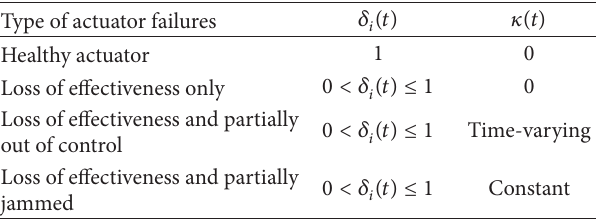
Table 1: Representations of typical actuator